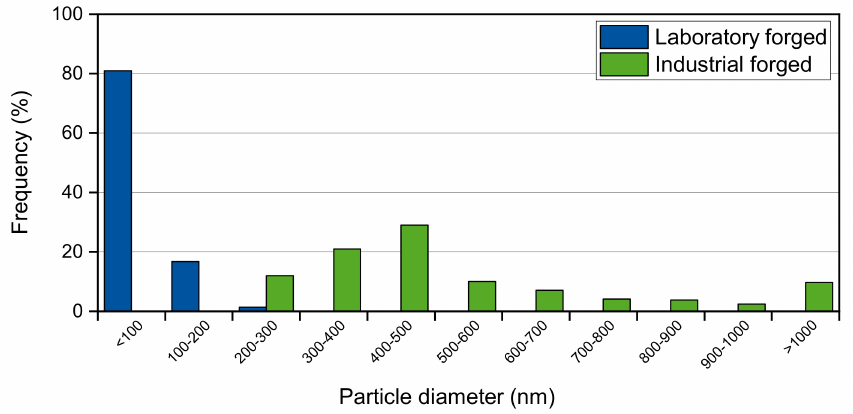
Figure 3. Particle size distribution of intergranular Laves phase precipitates after laboratory and industrial-scale forging experiments at 800 ◦ C and with a deformation grade of ϕ =